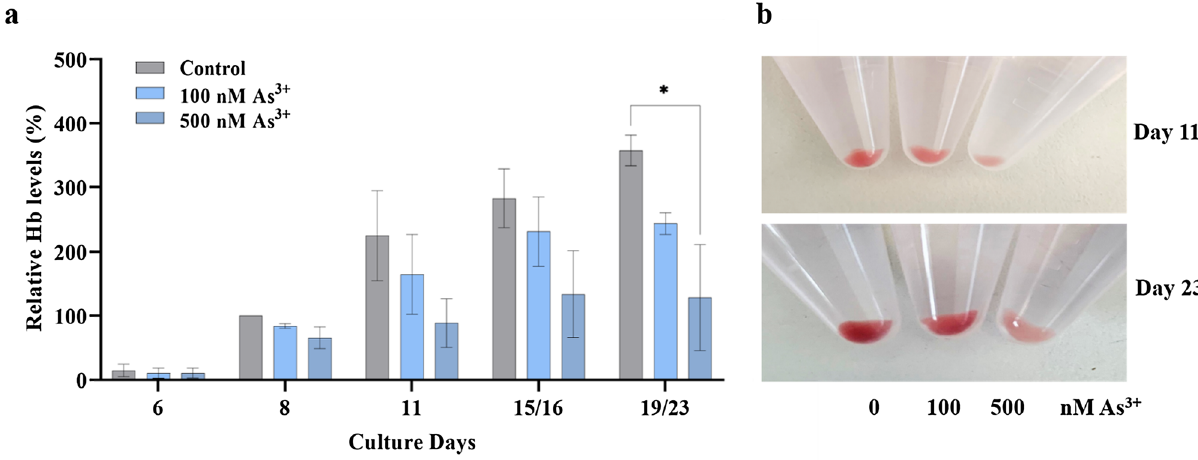
Figure 5. As 3+ exposure decreases hemoglobin (Hb) production during the erythroid development of CD34 + - HPCs. Human bone marrow CD34 + -HPCs were cultured in erythroid expansion medium for 6, 8, 11, 15 or 16 (15/16) and 19 or 23 (19/23) days in the presence of 0, 100 nM, or 500 nM As 3+ . Cell pellets collected at the indicated time points were imaged, and then lysed for cytoplasmic protein extraction. The cell lysates with a total protein concentration of 100 ng/mL were used for quantification of Hb using the Human HBB SimpleStep ELISA Kit (ab235654, Abcam). ( a ) Relative Hb levels at the different time points tested. Relative Hb levels were calculated as described in the methods section. ( b ) Representative images of cell pellets from control, 100 nM, and 500 nM As 3+ on days 11 and 23, which were from same donor (Donor 3). Data are expressed as summarized mean ± SD. *( p < 0.05) in one-way ANOVA, followed by Tukey’s post hoc test compared between